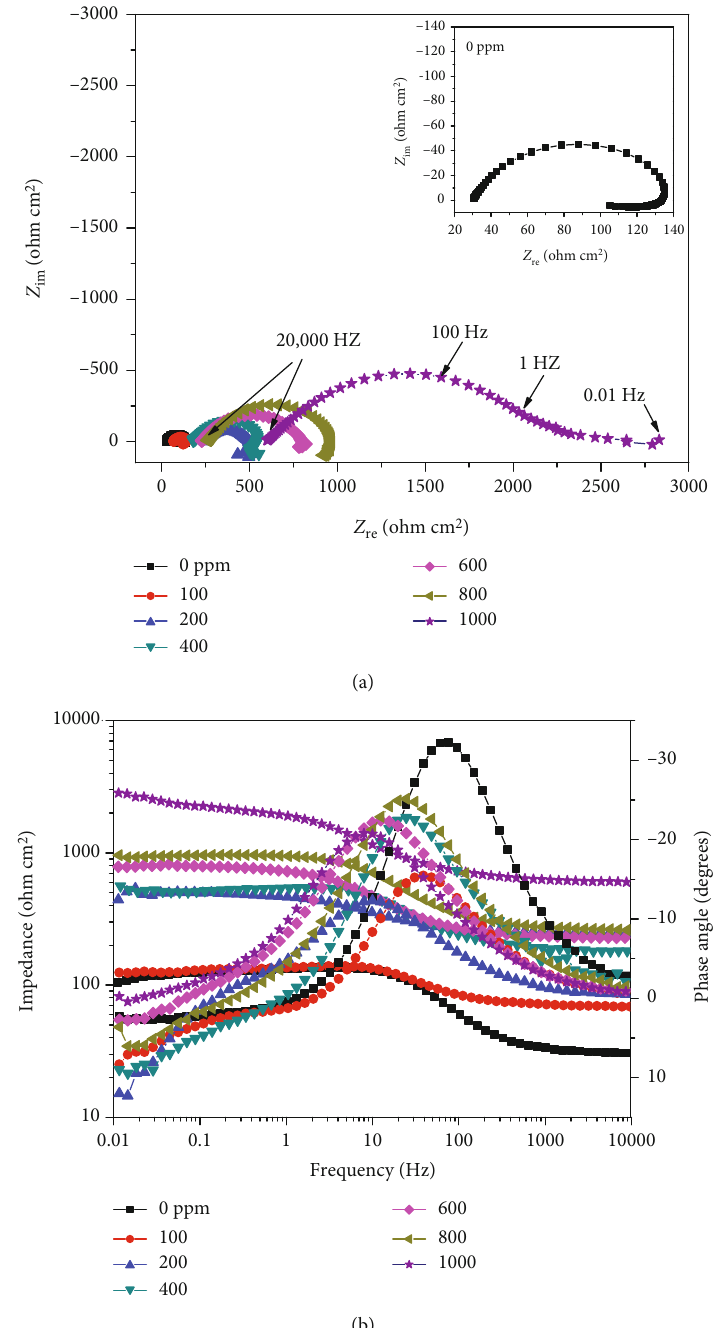
Figure 7: E ff ect of the Sn-metallic complex concentration on the (a) Nyquist and (b) Bode plots for 1018 carbon steel immersed in 0.5M SO H 2 4